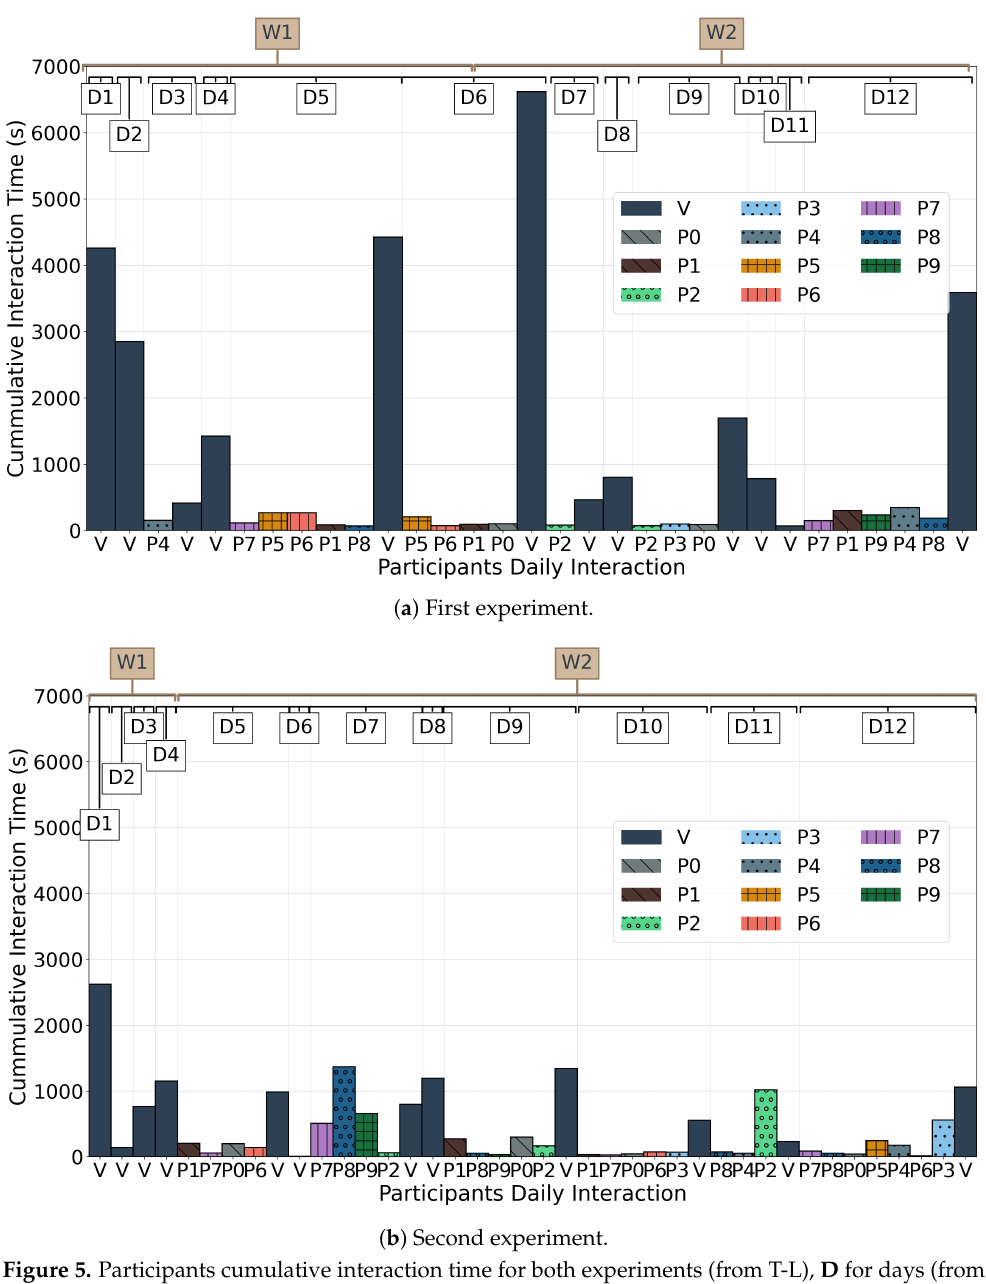
Figure 5. Participants cumulative interaction time for both experiments (from T-L), D for days (from 1 to 12), W1 and W2 for weeks; each bar corresponds to a user. New participants for E2 are denoted as P2 plus their respective tag numbers. The pattern for each participant represents the couple they belong to. Each bar corresponds to the cumulative interaction time that each SP and the V group had with Y¯okobo per day. The V group is also considered since their interaction is valuable to differentiate between groups and how each one decides to interact with the robot. The graphs also show that, on average, each SP left at least one message per experiment. This result, in combination with the data acquired through the questionnaire, allows us to discern patterns associated with the robot’s interactions, robustness, or personal perceptions, which (later on) is beneficial to discover the pain points associated with Y¯okobo’s interactions and qualifies the perceptual impacts it had on the